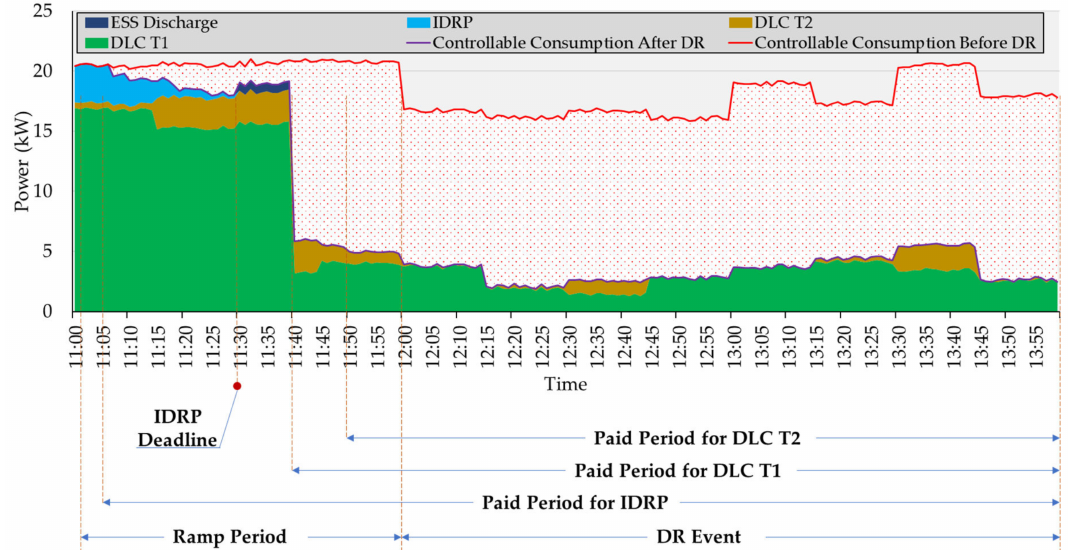
Figure 10. Results of applying demand response programs by the